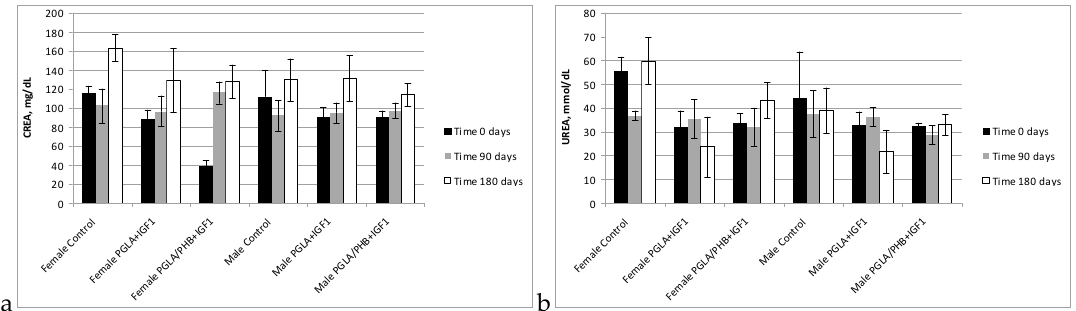
Figure 12. Glucose (GLU) ( a ) and cholesterol (HDL) ( b ) concentration in blood of rabbits. Molecules 2017 , 22 , 2092